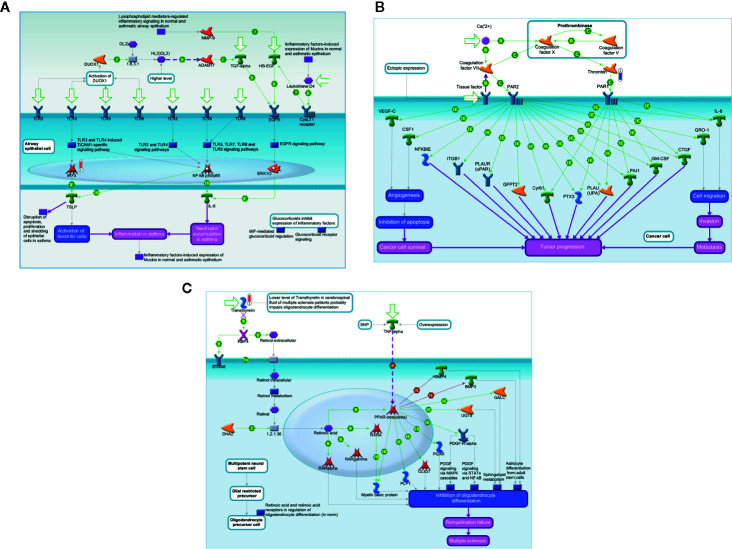

In silico analysis reveals the main biological networks differentially expressed in the blood of ALL-B compared to bone marrow in D28, at the end of treatment start. (A) TLR and EGFR-induced inflammatory signaling, (B) Expression targets of Tissue factor signaling in cancer, and (C) 7-Retinoic acid regulation of cell differentiation. Experimental data from all files are linked to and visualized on the maps as thermometer like figures. Upward thermometers have red color and indicate upregulated signals and downward (blue) ones indicate downregulated expression levels of the genes.